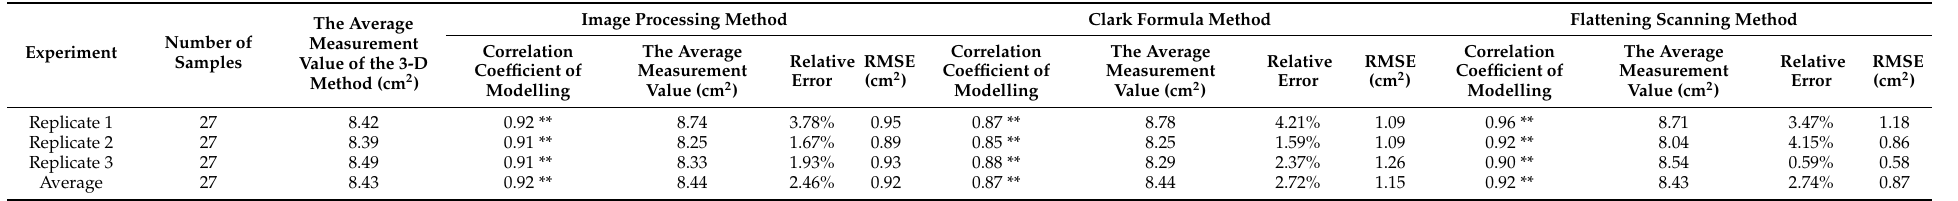
Table 3. Comparison of the accuracy of measurement of the correction results between the image processing method and the other two methods.